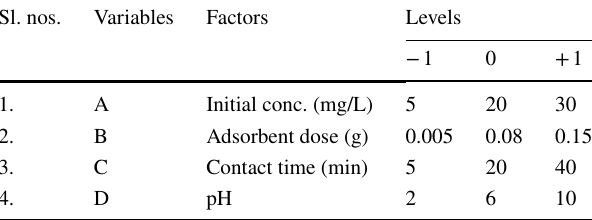
Table 4 Variables coded for adsorption parameters for analysis